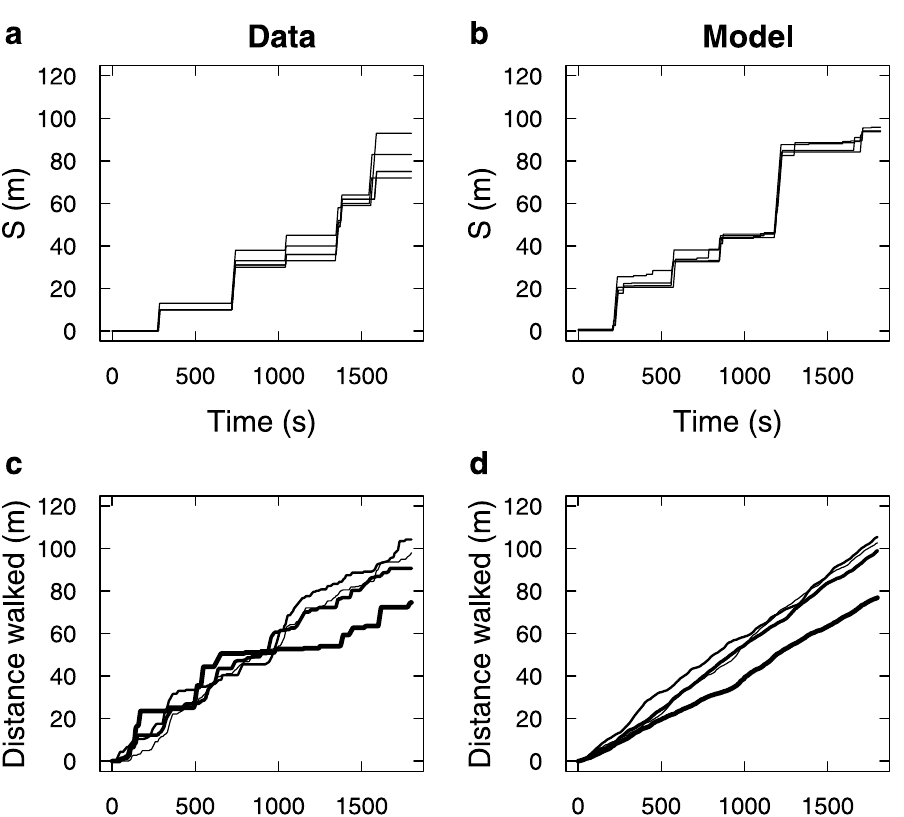
Fig 3. Individual-based model (IBM) prediction for 1D-propagation. (a) The evolution of one experimental group of 4 sheep is reported for illustration (same time-space representation as Fig 1d). (b) A typical evolution of a simulated 4-sheep group is reported for visual comparison with (a). This evolution is one stochastic realisation of the IBM, computed with an exact Monte Carlo (Gillespie algorithm was used), using the fitted rates and μ A = 0.0055 ( s − 1 ). (c) Average distance walked by experimental groups over 1800 s, for each group size separately (thiner line: N = 2, thicker line: N = 8). (d) Corresponding IBM predictions, averaging over 100 simulations per group size, like the one reported in